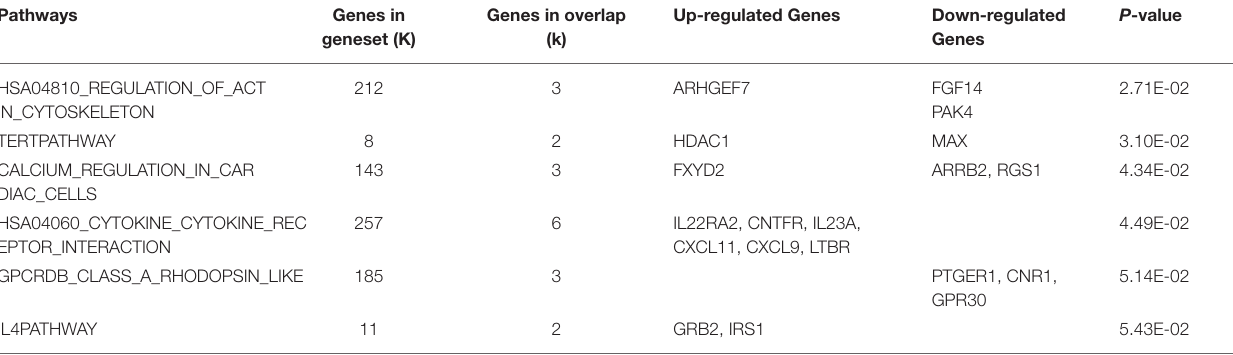
TABLE 4 | Analysis of the differential gene pathways of XYS group compared with the model group.